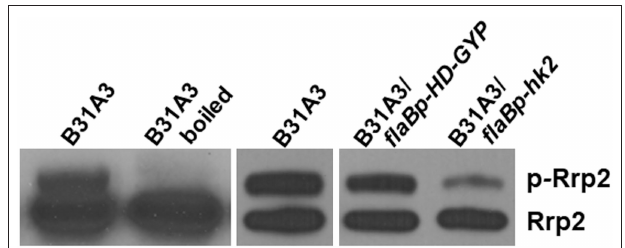
FIGURE 5 | Overexpressing HK2 reduces the level of phosphorylated Rrp2 in B. burgdorferi . Phos-tag SDS-PAGE and immunoblotting was used to detect both phosphorylated and dephosphorylated Rrp2 in the cell. Wild-type B. burgdorferi B31A3, B31A3 carrying a shuttle vector harboring a unrelated protein HD-GYP (B31A3 /flaBp-HD-GYP ), or B31A3 carrying a shuttle vector harboring a hk2 gene driven by a flaB promoter GYP (B31A3 /flaBp-hk2 ), were harvested at mid-log phase and cell lysates were prepared and separated on 7.5% SDS-PAGE containing 0, 5, 10, and 25 uM Phos-tag followed by immunoblotting using anti-Rrp2 antibody. p-Rrp2, the band corresponds to phosphorylated Rrp2. As a unphosphorylated Rrp2 control, B31A3 was also treated by boiling (lane 2) prior to Phos-tag SDS-PAGE (Rrp2 phosphorylation is unstable and sensitive to heat).